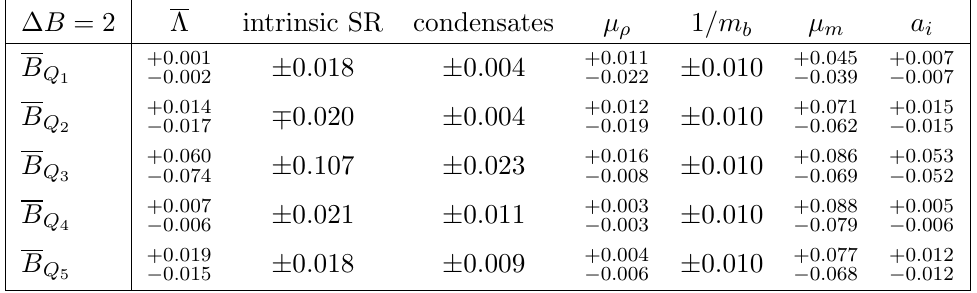
Table 2 . Individual errors for the Bag parameters of the (cid:1) B = 2 matrix